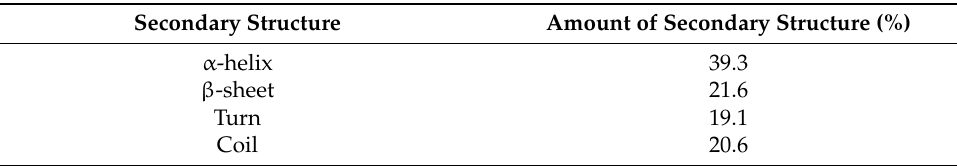
Table 5. Secondary structure determination of A. geothermalis